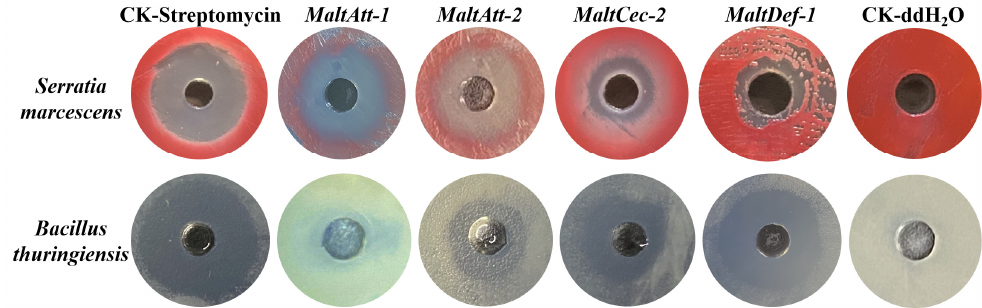
Figure 2. Bacteriostatic circles of M. alternatus AMPs protein.